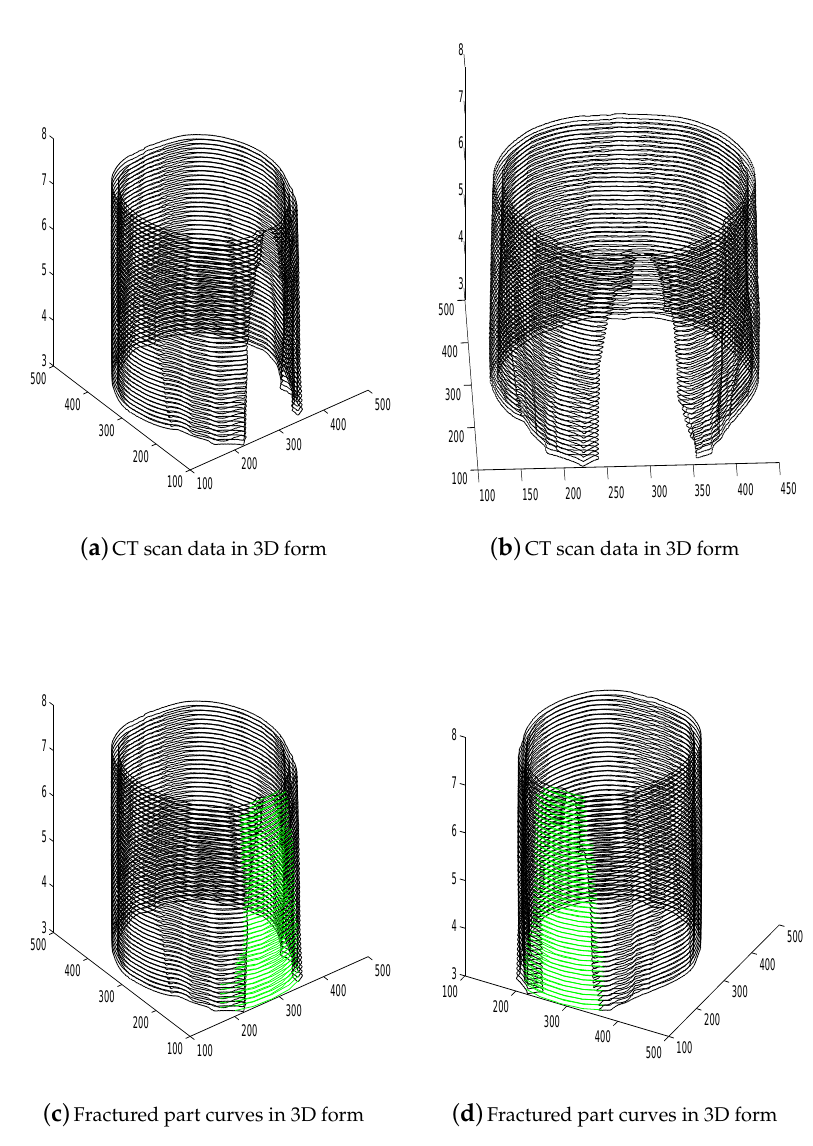
Figure 10. CT scan data slice 147.